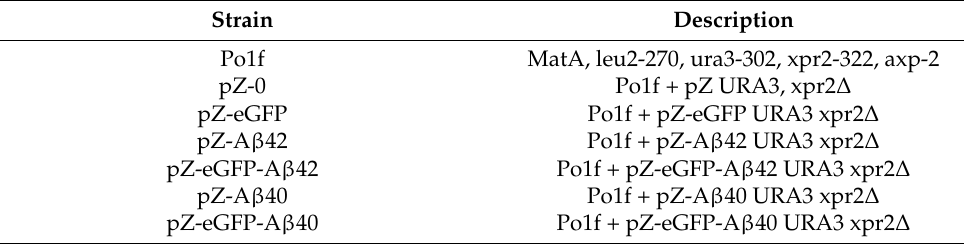
Table 1. List of